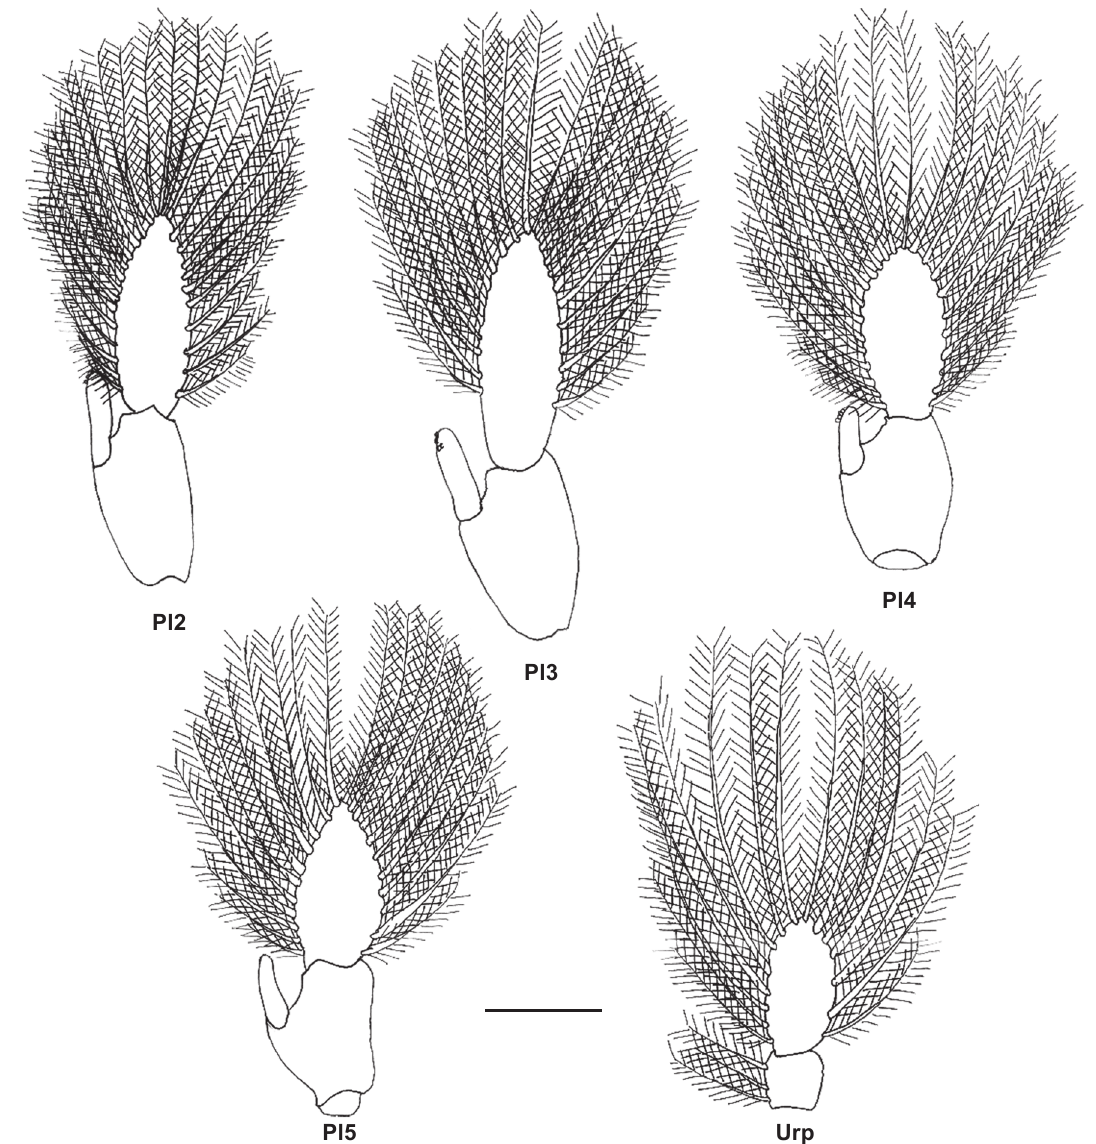
Figure 19. Pachygrapsus gracilis , megalopa. Pleopods (Pl2-Pl5) and uropod (Urp). Scale bar: 0.01